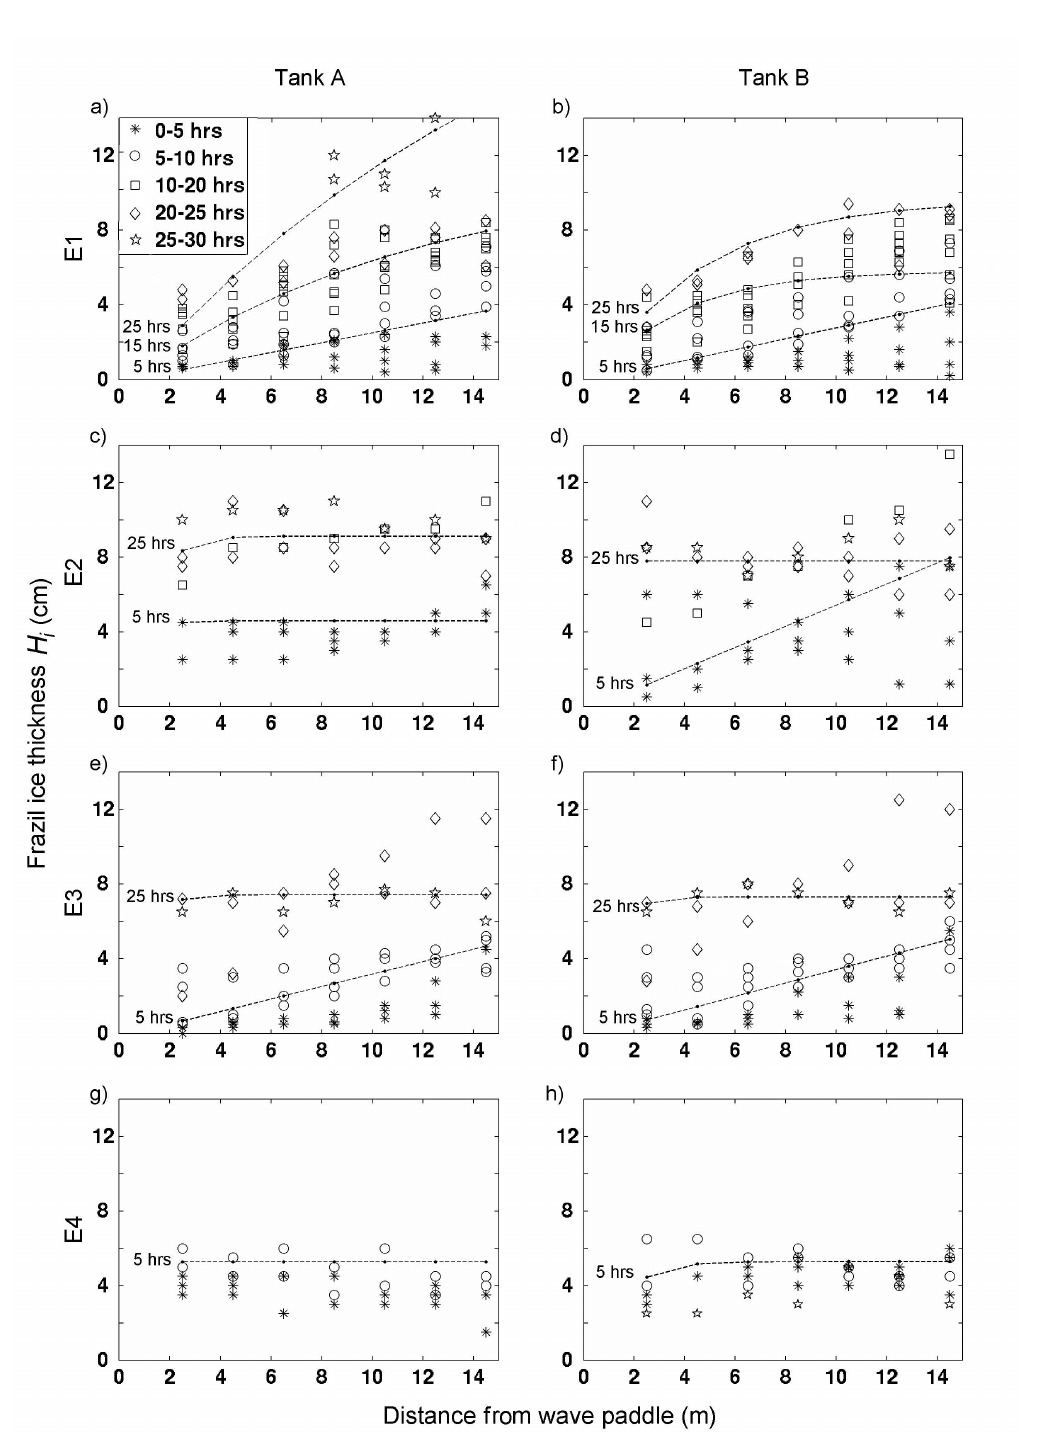
Fig. 3. Frazil ice thickness evolution along the tank for all experiments: (a) and (b) E1, (c) and (d) E2, (e) and (f) E3, (g) and (h) E4. Panels to the left display data from tank A, panels to the right display data from tank B. The dashed lines correspond to mean ice thicknesses (for 5, 15 and 25h where applicable) from the exponential fit discussed in Sect.